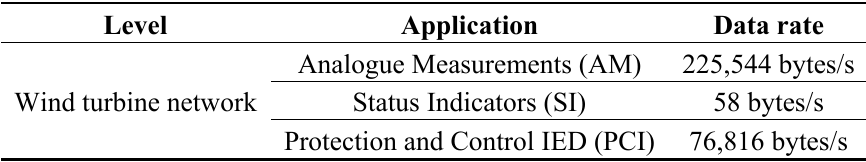
Table 6. Configuration of turbine area network (TAN).